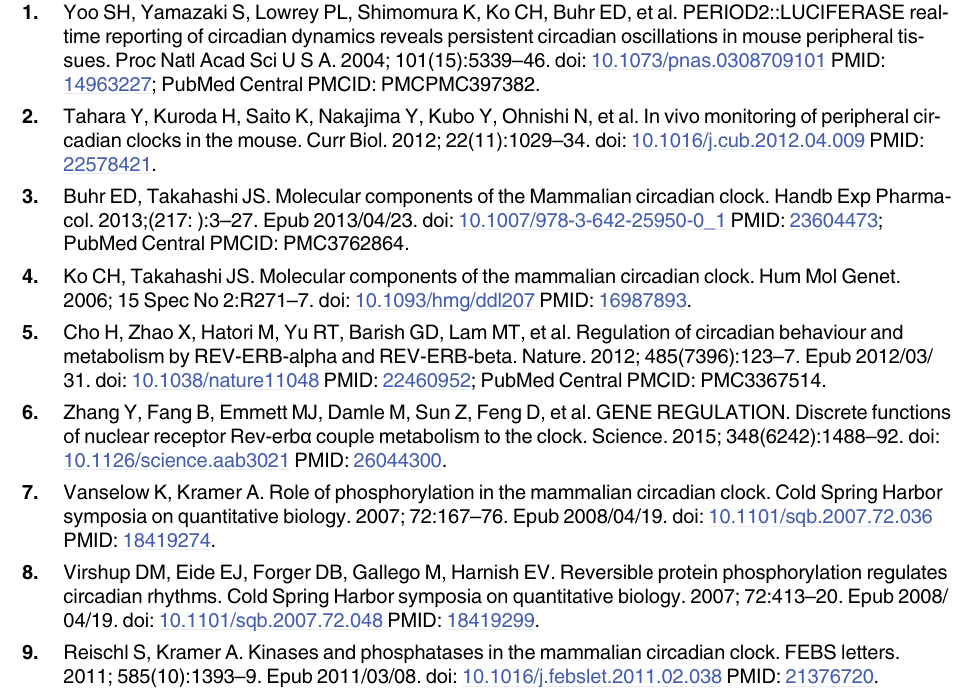
S1 Table. Cosinor analysis of GR circadian expression in WT and Lxr α -/- mice. Values are represented as median ± 95% bootstrap confidence intervals. (cid:1) indicates significant differences between females vs males, † indicates significant differences between Lxr α -/- vs WT mice. Cir- cadian rhythmicity was considered significant for a p -value < 0.05; NSR, not significantly